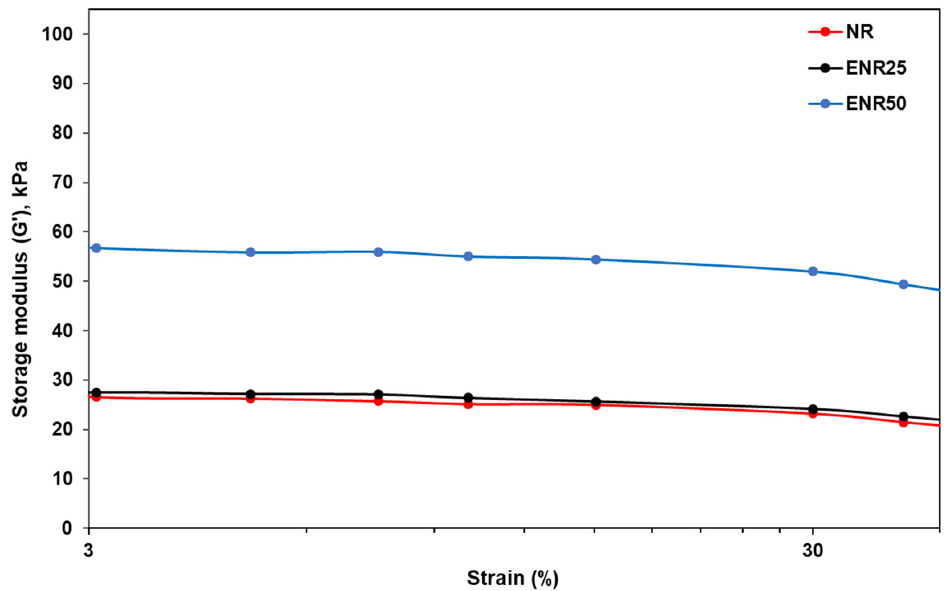
Figure 8. Storage modulus (G’) against %strain (3–40%) of NR-Clay, ENR25-Clay and ENR50-Clay composites at the mixing temperature of 80 ° C prepared by dispersing bentonite in Et-OH solution. Figure 9 shows the XRD patterns of NR-Clay, ENR25-Clay and ENR50-Clay com- posites. The ENR25-Clayet composites exhibited peaks at the diffraction angles 22.94°, 26.8° and 28.13°. Pointed peaks are observed at 22.71°, 26.42° and 28.15° in case of ENR50-Clayet composites. In cases of NR-Clay, ENR25-Clay and ENR50-Clay compo- sites, the broad peak in the range of 12–24 degree shifts to lower side. Furthermore, the angles slide to lower the angle from 19.94, 19.91 and 19.42, respectively. Additionally, the ENR50-Clay composite shows the displacement of peaks at 10.03° and 29°. This is at- tributed to the impregnation of elastomeric phase into the silicate galleries, hiding the regular stacked-layer structure of the modified bentonite clays and extends to an inter- calated structure. Moreover, intensity of the sharp peak (characteristic peak) is also higher on increasing the epoxy degree in ENR composites. Dominantly, the intensity of diffraction peak at 10.03° is slightly higher than 9.99 and 9.9°. The d-spacing is found to be increased from 3.87 to 4.92 nm at 19.98°, 19.91° and 19.20° as shown in Table 4. It ex- hibits the intercalation of rubber molecules in between the layers of bentonite clay. Fur- thermore, the polarity of the modified NR (ENR) supports intercalation of elastomer chain into the modified bentonite clay leads to better intercalation and dispersion in the matrix [23,24].